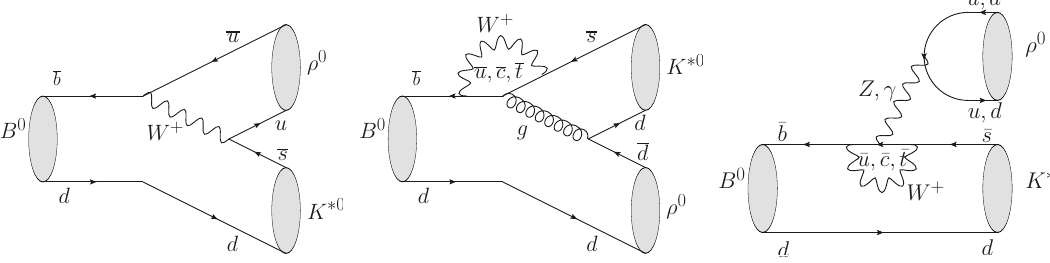
Figure 1. Leading Feynman diagrams in the B 0 Cabibbo-suppressed tree, gluonic-penguin and electroweak-penguin